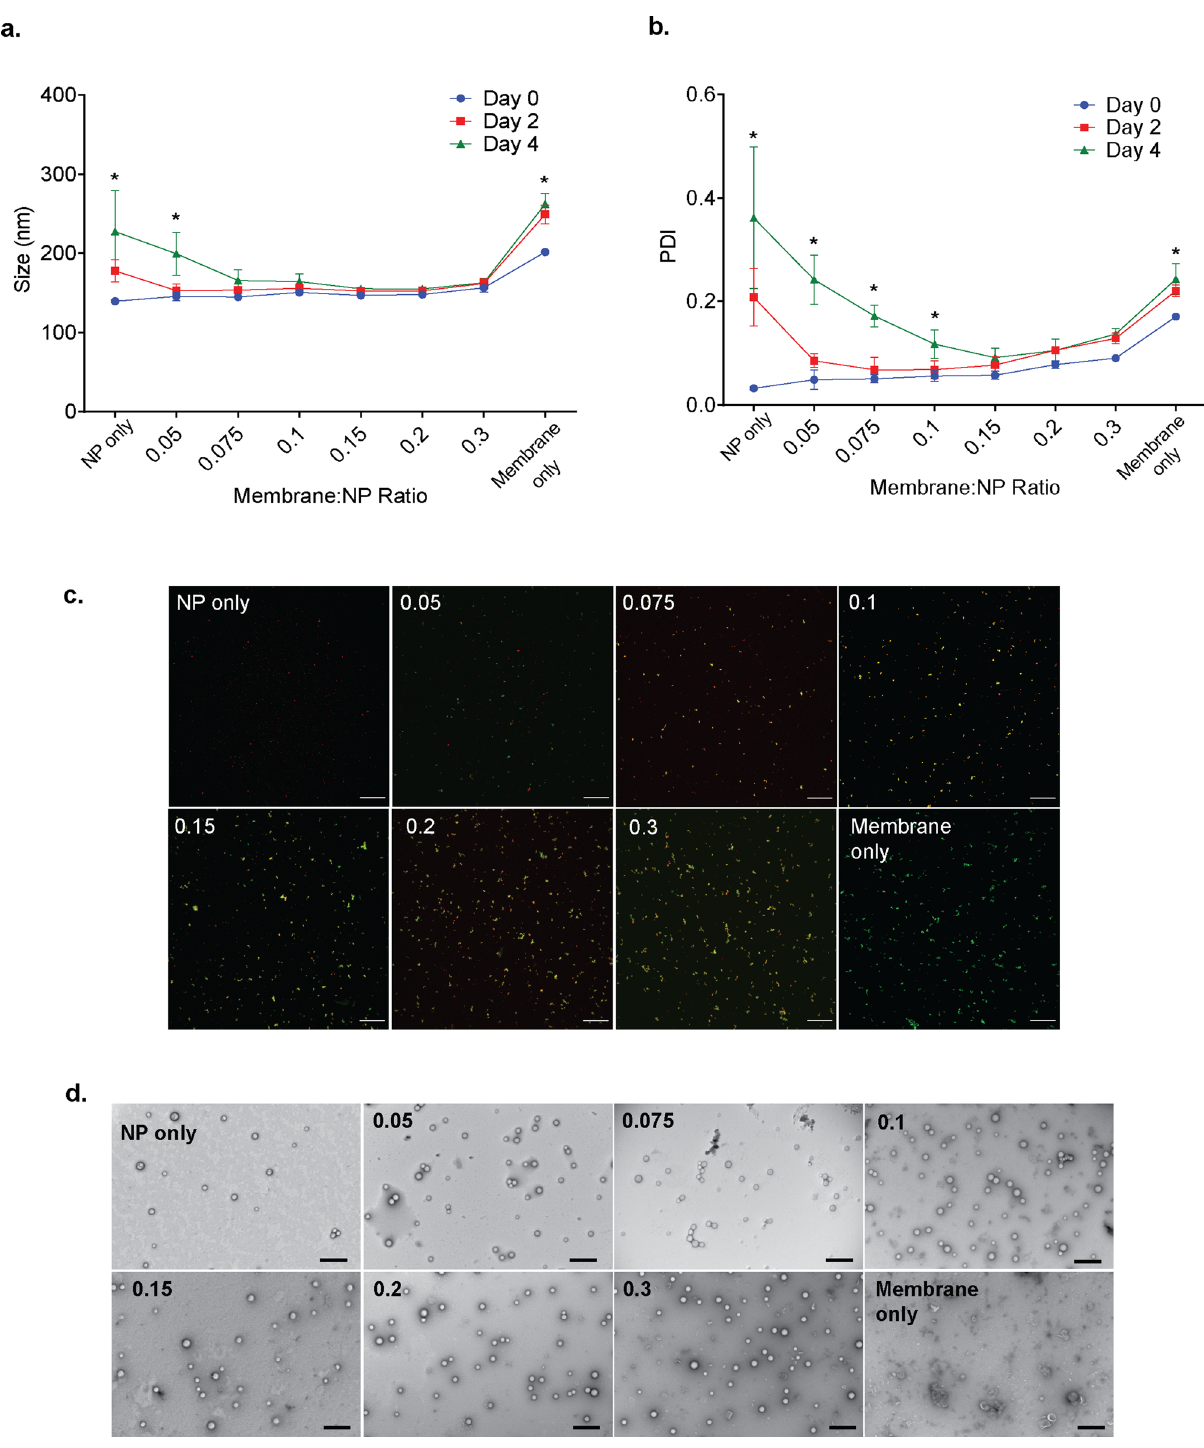
Figure 4. Effect of the ratio of membrane vesicles to nanoparticle cores on the efficiency of NP coating. Co-suspensions of different indicated ratios of membrane vesicles and PLGA nanoparticles (NPs) were sonicated (5 min., 15 °C, 60%) to induce membrane coating and then incubated at room temperature or under constant agitation (360° rotation at 8 rpm). ( a ) Size (nm) and ( b ) polydispersity index (PDI) were assessed by dynamic light scattering on Day 0 (after sonicating), Day 2, and Day 4. Data shown are the mean ± SD, n = 3. * p < 0.001 Day 0 versus Day 4 for the indicated ratios, 2-way repeated measures ANOVA with Dunnett’s post hoc test. ( c ) Representative confocal images depicting sonicated co-suspensions of indicated ratios of membrane vesicles (labeled with DiO, green) to NP cores (loaded with DiD, red) on Day 0. Yellow indicates co-localization of NPs and membrane vesicles. Images of data represented by the blue line in A and B. Scale bar: 20 μm. ( d ) Representative transmission electron microscopy images depicting sonicated co-suspensions of indicated ratios of vesicles and cores after 4 days of constant agitation (represented by the green line in A and B). Scale bar, 400